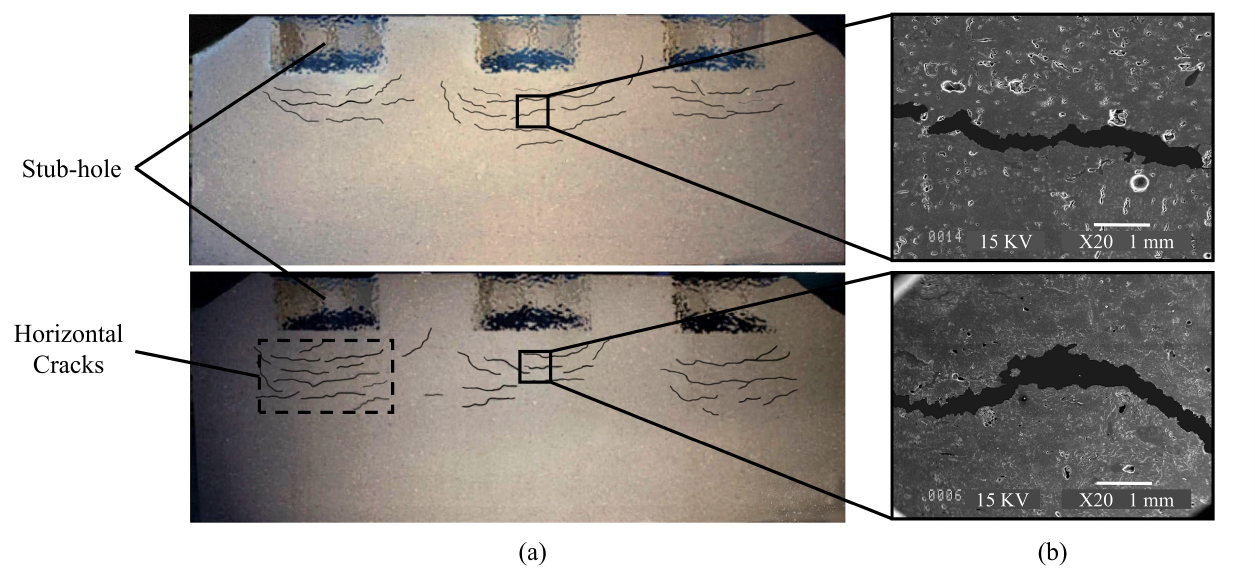
Figure 1. ( a ) Images of the horizontal cracks under the carbon holes of the anodes, which were obtained after cutting the anodes made in the Alcoa Deschambault Québec (ADC) (The size of the cracks has been magnified for greater clarity), ( b ) Images of the cracked area by Scanning Electron Microscope